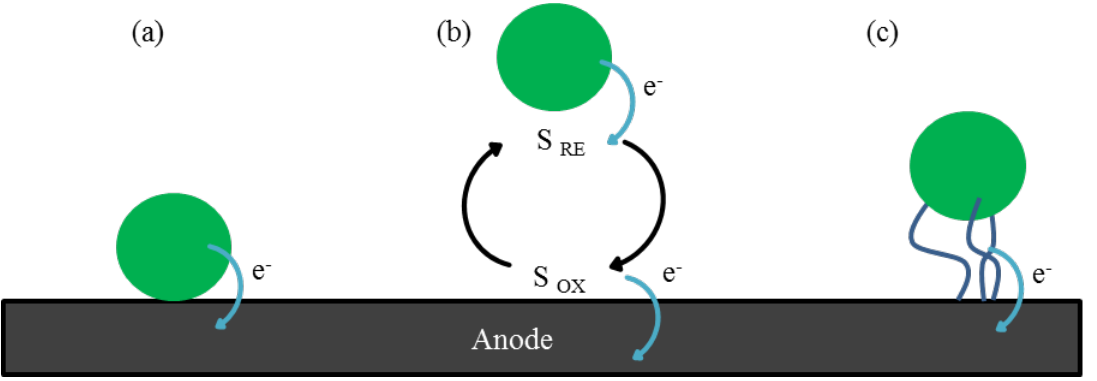
Figure 2. A schematic of three electron transfer mechanisms of microbes at the anode surface: ( a ) direct transfer by contact; ( b ) indirect electron transfer by redox shuttles (S = reduced electron shuttle, S = oxidized electron shuttle); ( c ) electron transfer by RE OX conductive nanowire